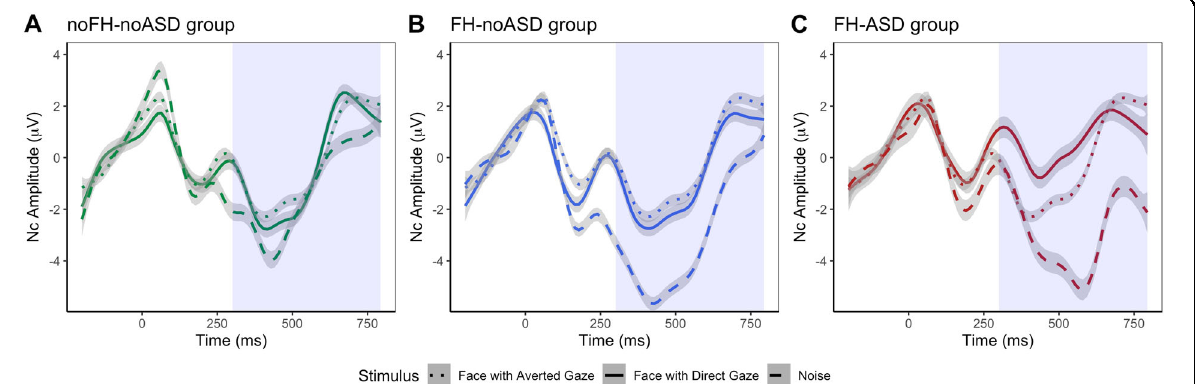
Fig. 1 Anterior event-related potentials for the three ASD liability groups. Illustration of the grand average ERPs over the frontal electrodes at 8 months for the noFH-noASD ( A ), FH-noASD ( B ) and FH-ASD ( C ) groups, with shaded area highlighting the Nc time window (x-axis, 300 – 800 ms). ERP data have been smoothed for representation purposes using the ‘ gam ’ function of the ‘ ggplot2 ’ package in R 92